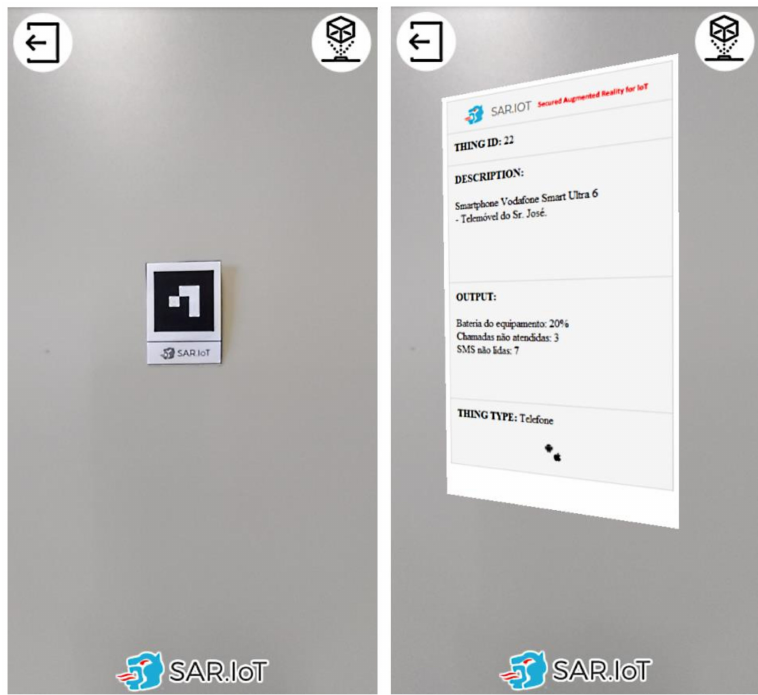
Figure 11. AR marker ( left ) being detected and processed ( right ).